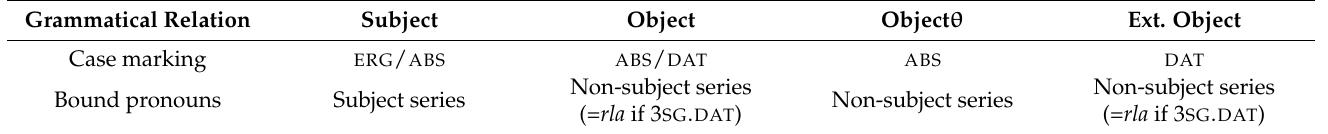
Table 3. Identifying core grammatical relations in Warlpiri, including external